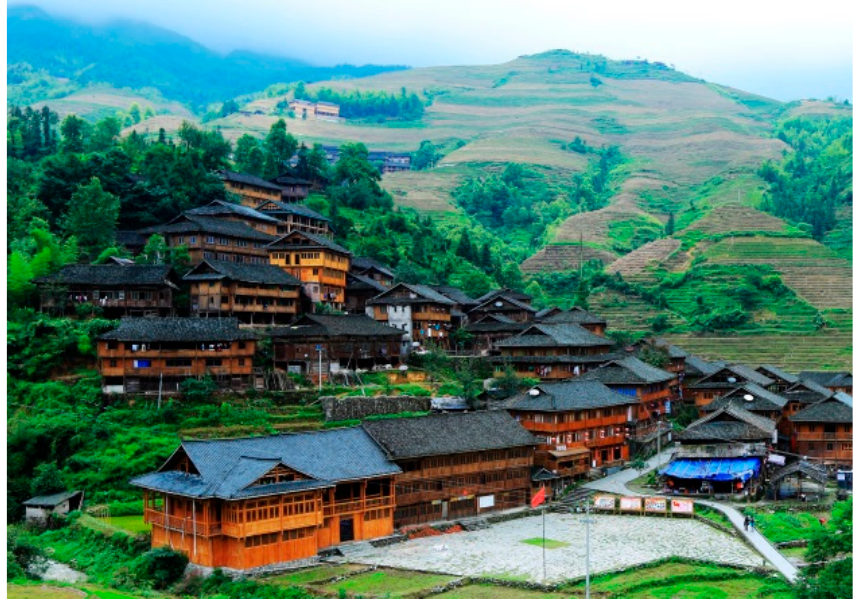
Figure 3. One natural village in Dazhai.